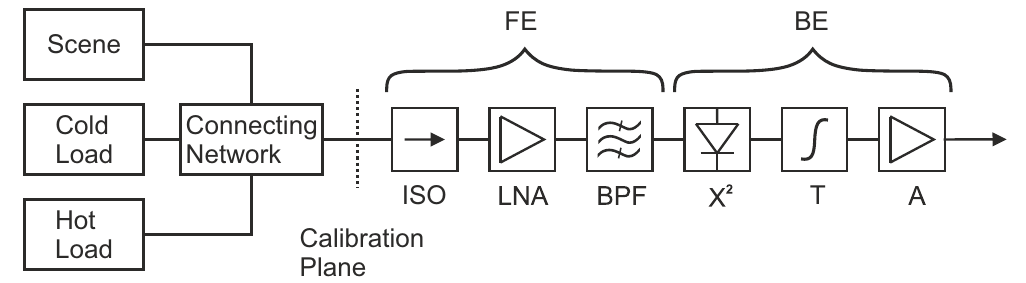
Figure 1. Simplified total power radiometer block diagram.